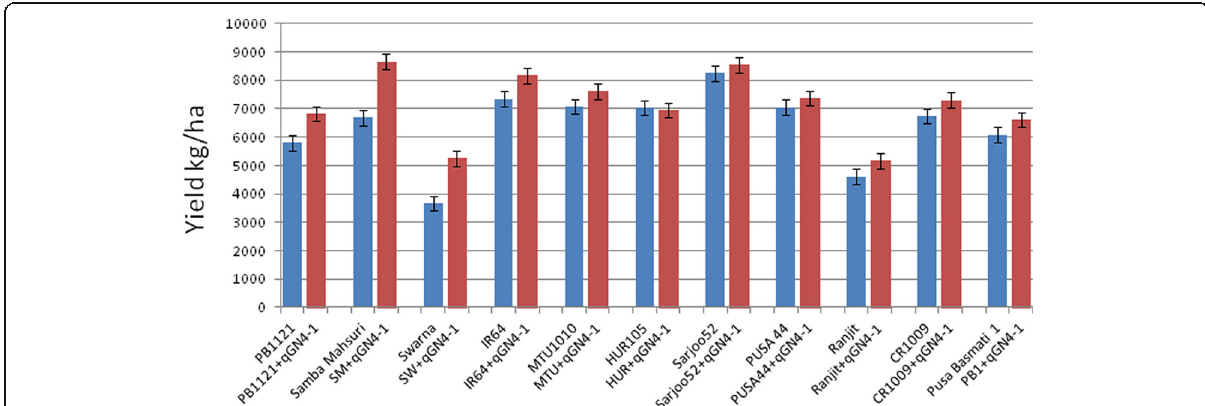
Fig. 6 Bar diagram showing yield performance of qGN4. 1 QTL-NILs in 11 different backgrounds of rice in comparison to their recipient parents. Values are average of two replications, with the whiskers showing S.E. of means. SM = Samba Mahsuri; SW = Swarna